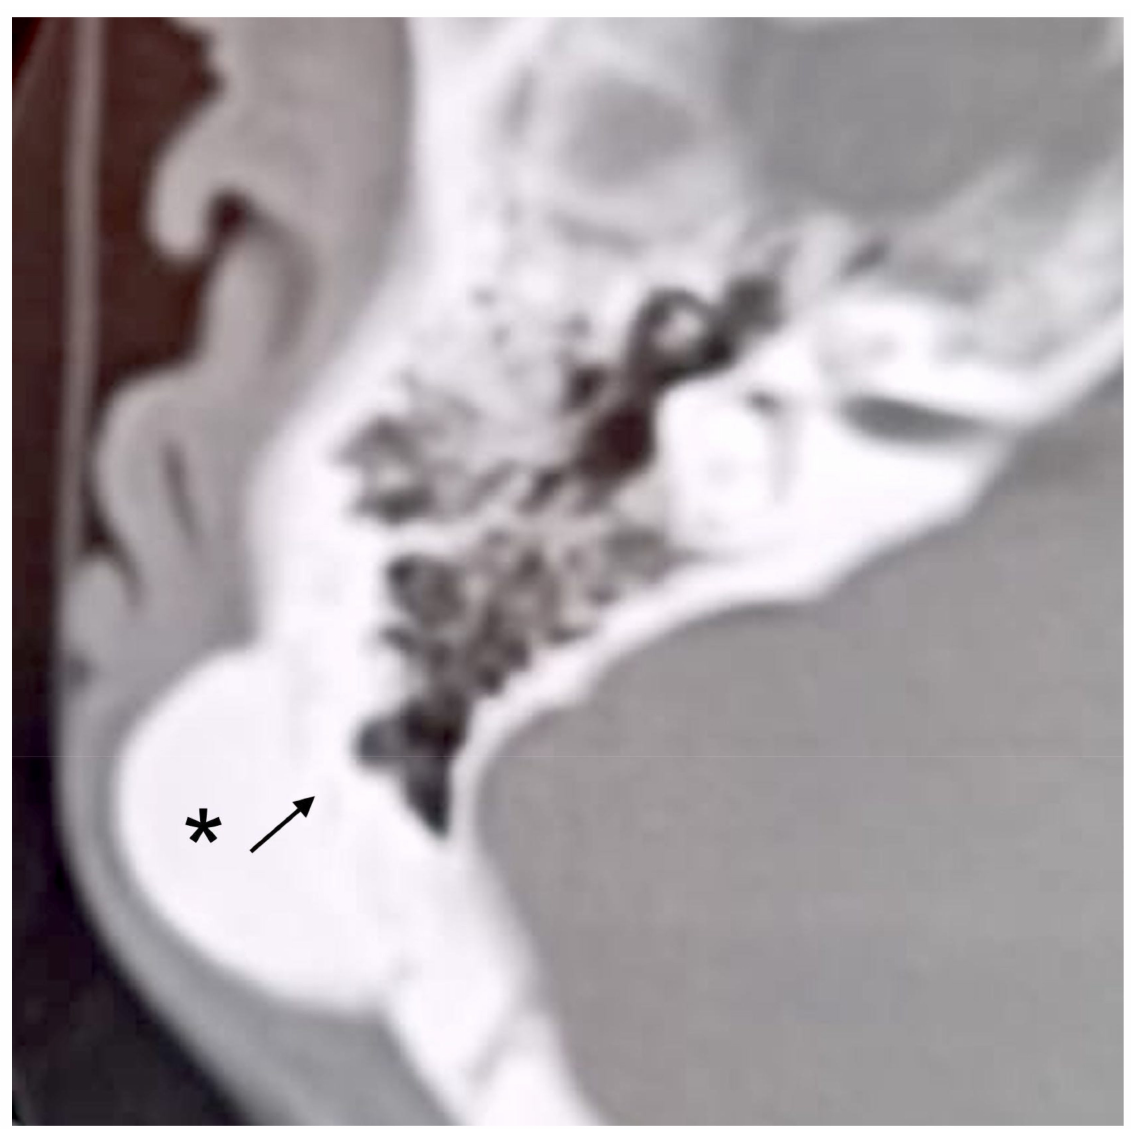
Figure 3. Axial CT scan. Right mastoid cortex osteoma (asterisk) with a subtle line margin